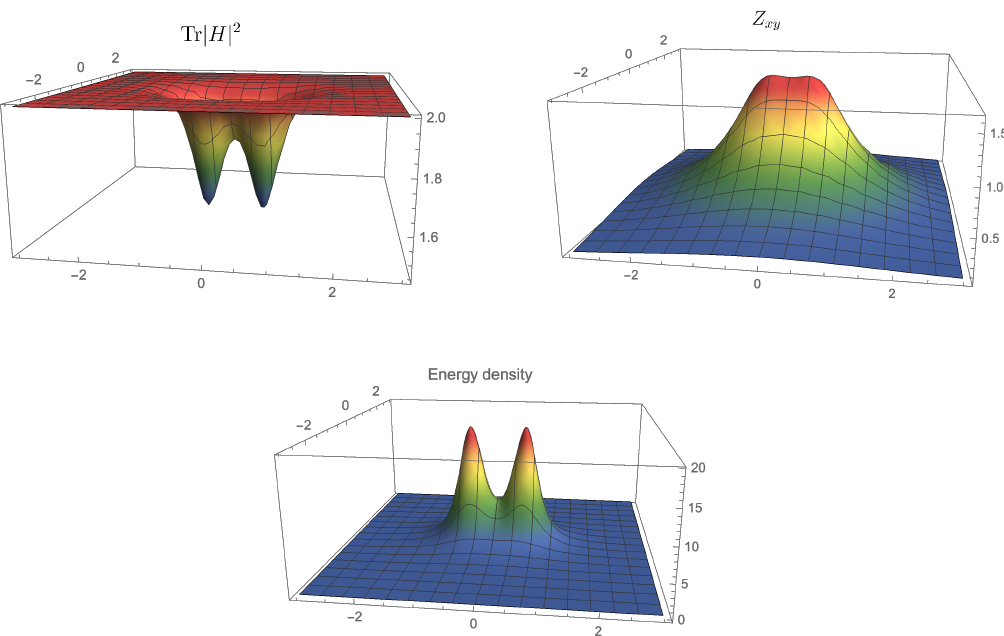
the Higgs field Tr | H | 2 , Z -flux Z xy , and the energy density, respectively, in the xy plane. The parameters are taken as the text (eqs. (6.2)). The length unit is taken so that v (= 123 GeV) = 1 .